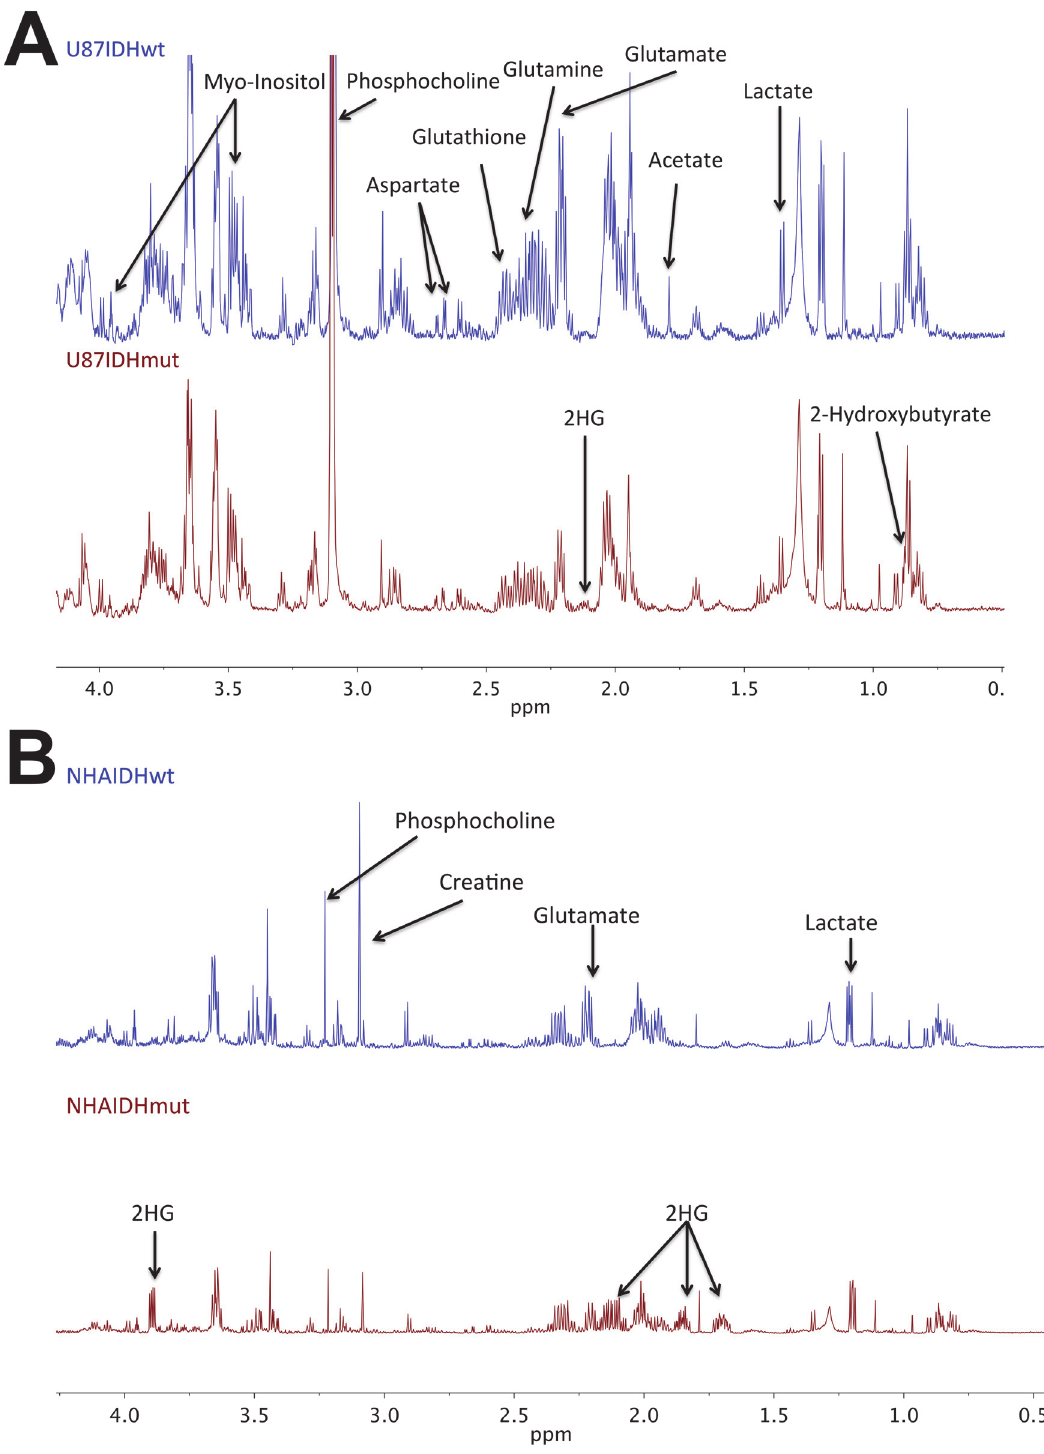
Fig 4. Metabolic differences between IDHwt and IDHmut cells are highlighted by the PCA. The representative aliphatic portions of the 1 H-MRS spectra of IDHwt (blue, top panel) and IDHmut (red, bottom panel) cell extracts are shown for U87 (A) and NHA (B).